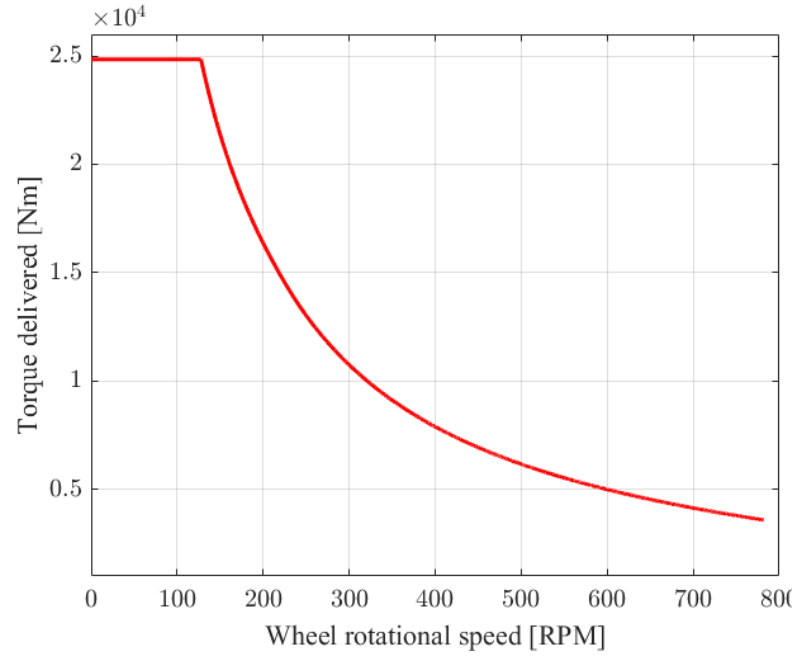
Figure 4. Torque limit curve in diesel propulsion